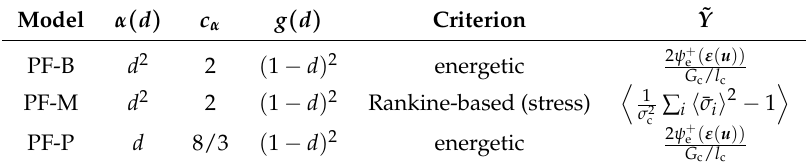
Table 2. Phase-field formulations and corresponding functions and parameters. For the PF-M model, the Macaulay brackets are defined as the tensile strength, and ¯ σ i are the principal components of the effective stress